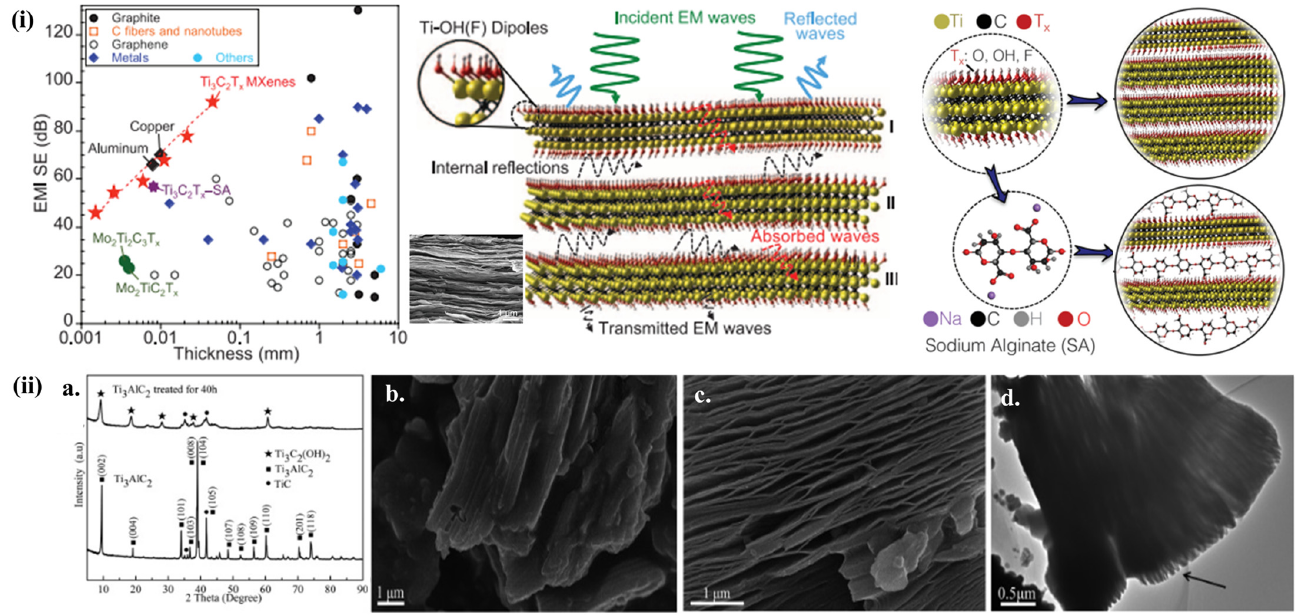
Figure 7. ( i ) An exemplification of TC and TC-SA composite with EMI SE, ( ii ) ( a ) XRD, and ( b – d ) SEM/TEM images before and after HF treatment on MAX [68].